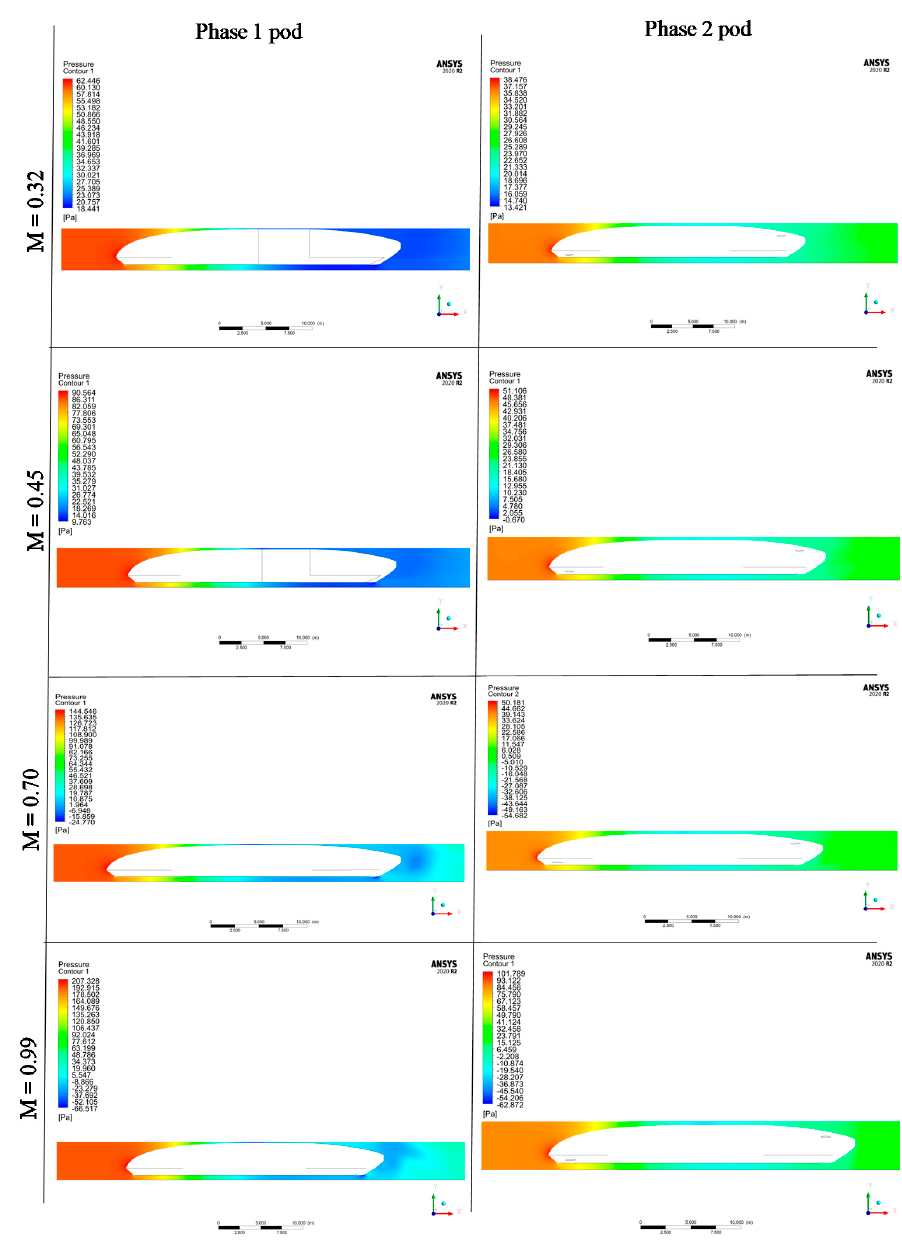
Figure 12. A comparison of the pressure contours around the two pods. The pressure in all the cases is maximum at the front of the pod, especially around the nose.